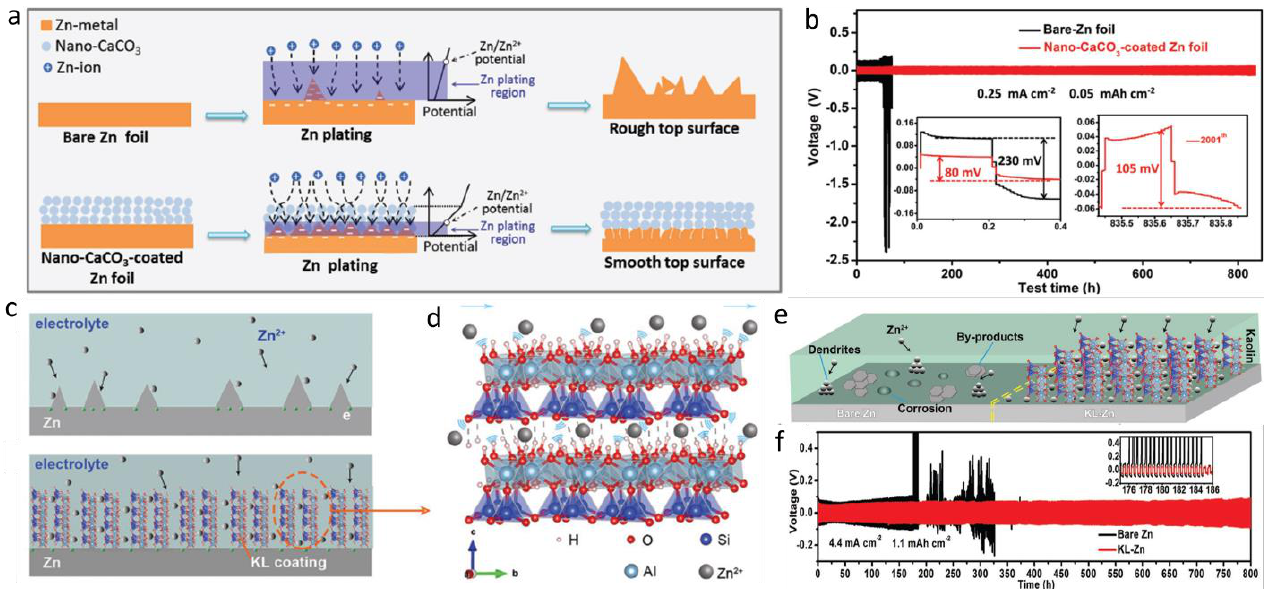
Figure 6. ( a ) Schematic diagrams of the morphological evolution of bare Zn and nano-CaCO 3 -coated Zn during Zn plating/stripping cycling. ( b ) Typical GCD profiles of Zn|ZnSO 4 +MnSO 4 |Zn symmetric cells with bare Zn and nano-CaCO 3 -coated Zn electrodes (Reproduced with permission. [84] Copyright 2018, John Wiley & Son). ( c ) Schematic diagrams of Zn deposition process on bare Zn and KL-Zn. ( d ) Schematic representation of confined Zn 2+ transmission in kaolin. ( e ) Schematic illustrations of morphology transformation of bare Zn and KL-Zn anodes during Zn 2+ deposition process. ( f ) Long-term galvanostatic cycling results of symmetrical cells with bare Zn and KL-Zn electrodes (Reproduced with permission. [86] Copyright 2020, John Wiley & Son).